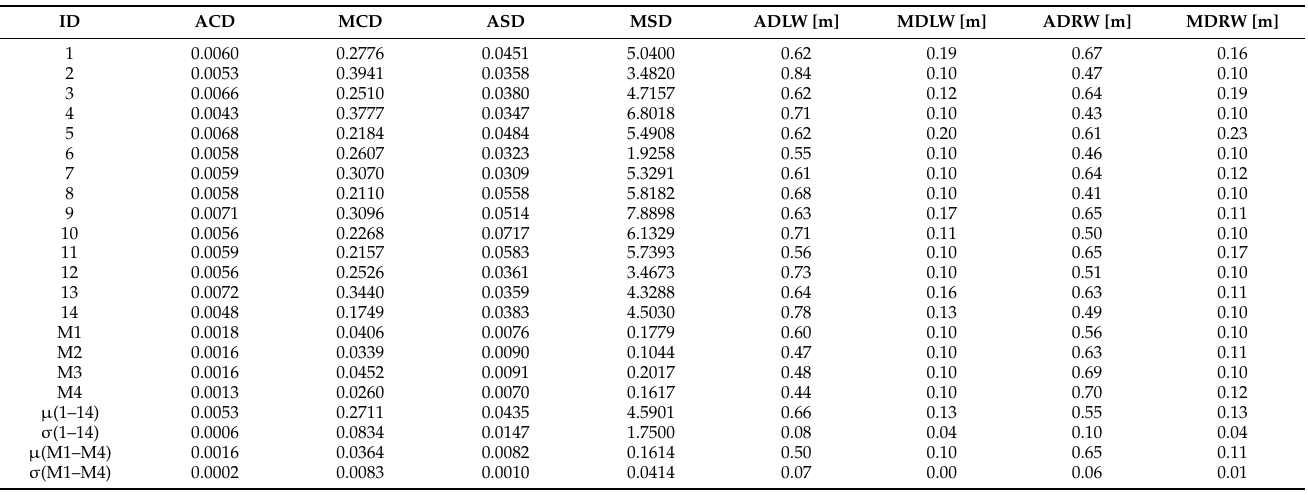
Table 4. LHD input difference, state difference and distance to the walls for autonomous navigation and manual operation. ID: Dataset Identifier. ACD: Average Command Difference ( E u ). MCD: Max Command Difference ( E u ). ASD: Average State Difference ( E LHD ). MSD: Max State Difference ( E LHD ). H F/B: Heading Forward or Backwards. ADLW: Average Distance to Left Wall. MDLW: Minimum Distance to Left Wall. ADRW: Average Distance to Right Wall. MDRW: Minimum Distance to Right Wall.